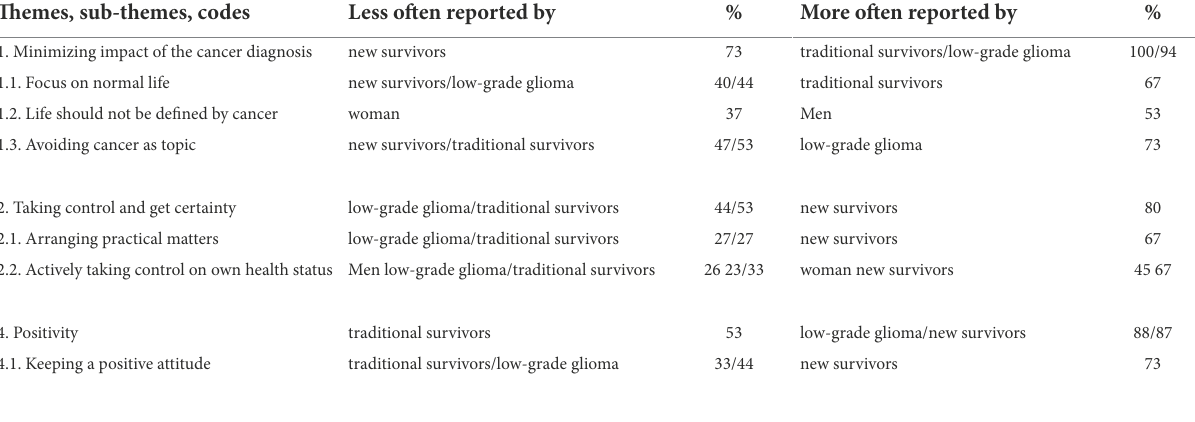
TABLE A1 Themes and sub-themes with remarkable differences between AYA subgroups. Themes, sub-themes,